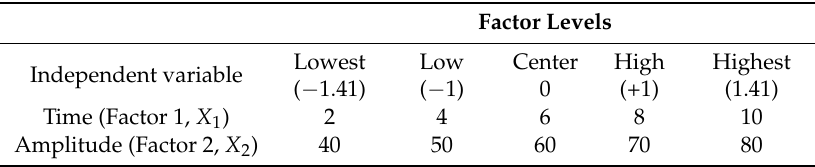
Table 1. Independent variables and their levels in the response surface